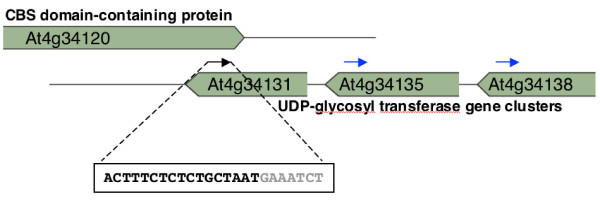
An example of one putative nat-siRNA (black arrow, sequence is indicated in the box) that can potentially silence all three UDP-glycosyl transferase genes: At4g34131, At4g34135 and At4g34138. Blue arrows indicate two more target sites.